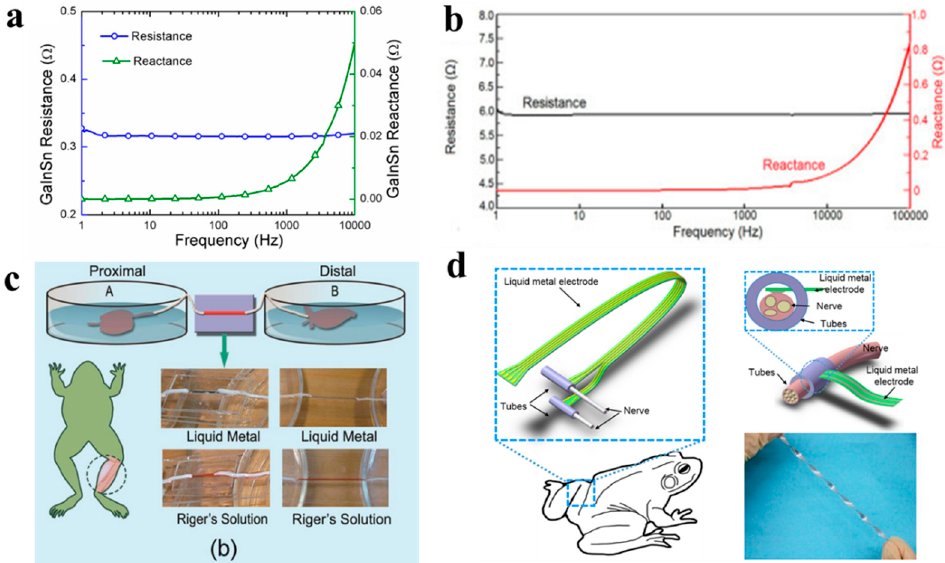
Figure 11. Applications in nerve connection. ( a ) The impedance curve of the GaInSn. Copyright (2014) by the authors [117]. ( b ) The impedance of gallium for signals with different frequencies [66]. Copyright (2016) Science China Press. Published by Elsevier B.V. ( c ) The schematic diagram of the transected sciatic nerve reconnected by liquid metal and Riger’s Solution, respectively [117]. Copyright (2014) by the authors. ( d ). The liquid metal nerve electrodes and the machining process